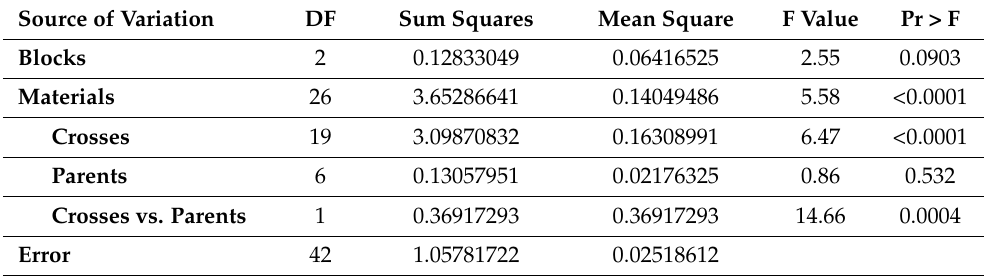
Table 3. Analysis of variance for market yield in Set 2. DF = degrees of freedom. Pr = p -value. The model adjustment (R 2 ) and error coefficient of variation are presented at the bottom of the table. Source of Variation DF Sum Squares Mean Square